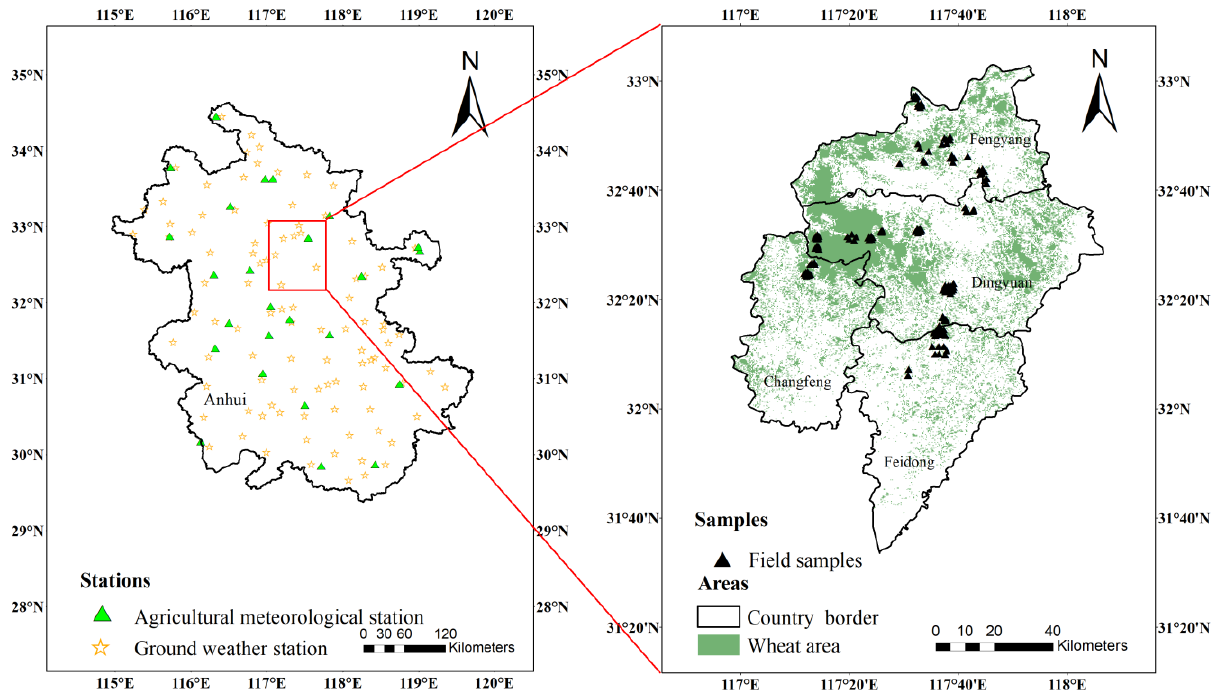
Figure 1. Study area and sampling